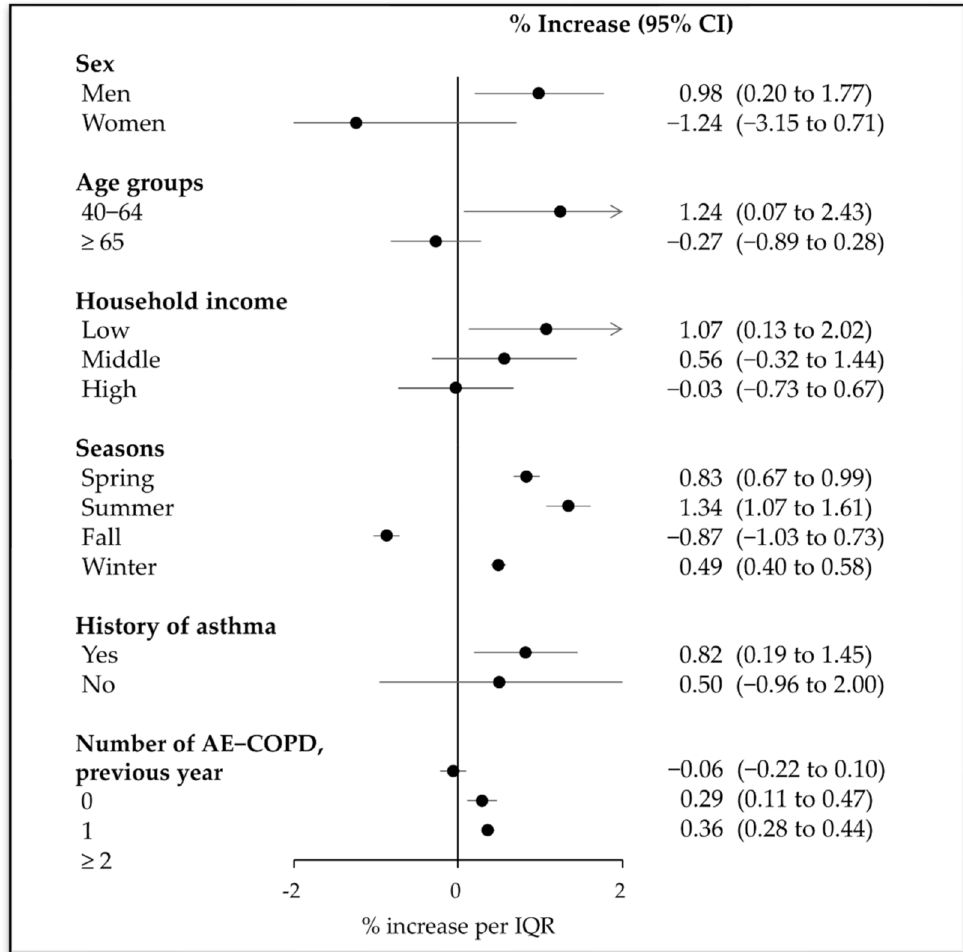
Figure 2. Percent increase in acute exacerbation of chronic obstructive pulmonary disease associated with an interquartile range (IQR) increase in PM 10 after stratification for various factors (cumulative lag 3). After adjusting for national holidays and natural cubic spline variables (mean temperature, dew point temperature, and air pressure), the IQRs were PM 10 , 25.50 µ g/m 3 . PM 10 , fine particulate matter with a median aerodynamic diameter of ≤ 10 µ m; CI, confidence interval; AE-COPD, acute exacerbation of chronic obstructive pulmonary disease. The arrow at the end of the line means that the CI extends over the range of x -axis.